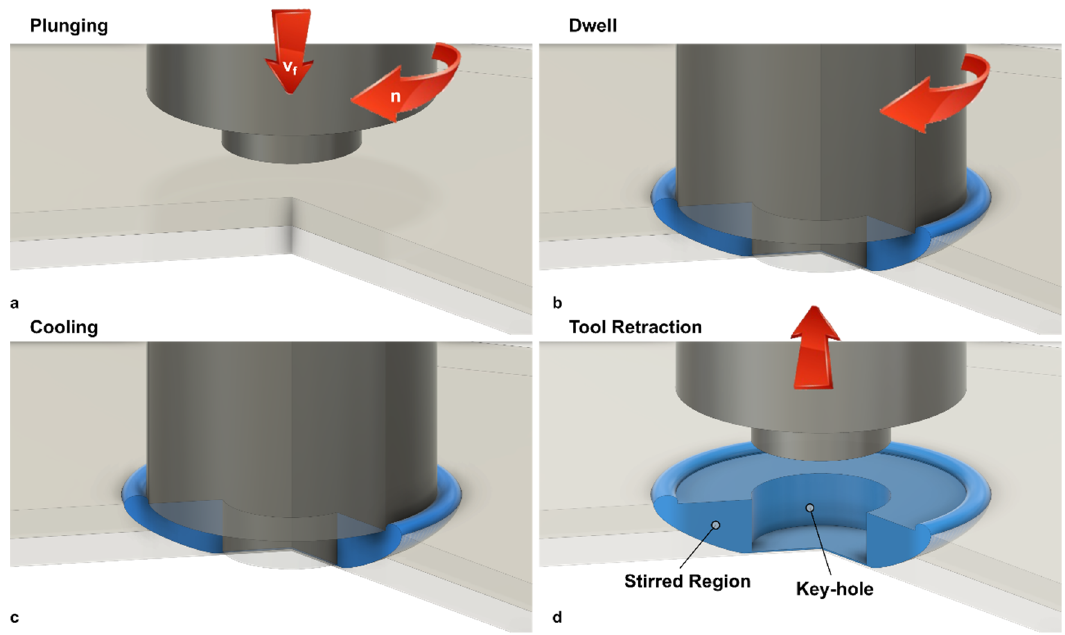
Figure 23. Main phases of FSSW development: ( a ) plunging; ( b ) dwell; ( c ) cooling and ( d ) tool retraction.